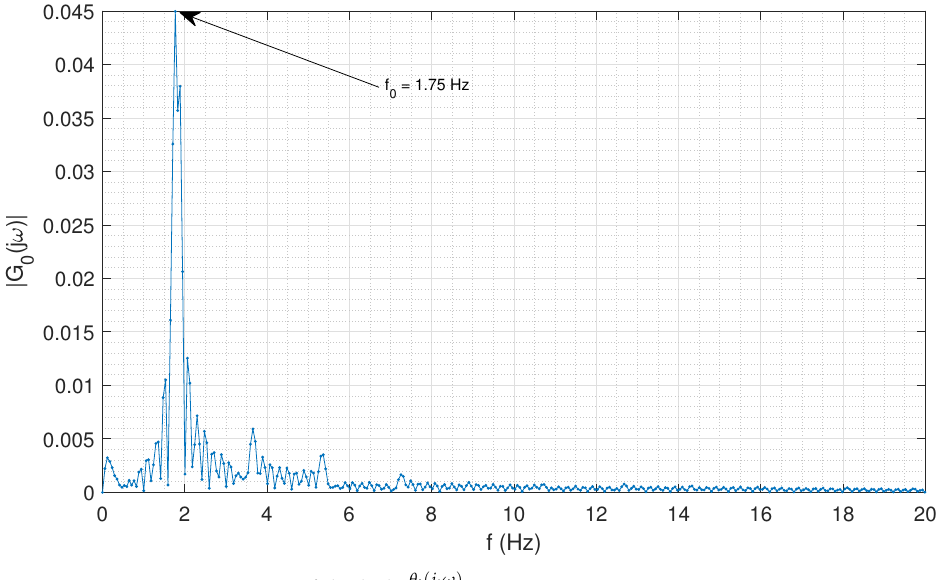
Figure 6. Frequency response of the link θ t ( j · ω )